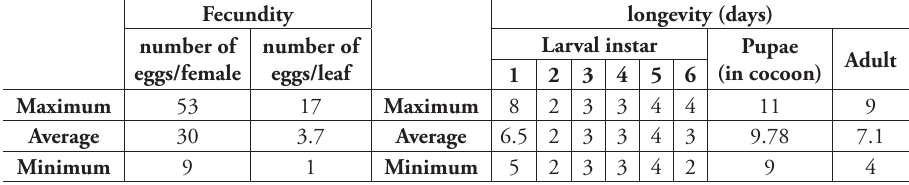
Table 1. Fecundity and longevity of N. oligospilus in laboratory. Females, n= 15; pupae, n = 15; larvae, n= 11 (from several instars); eggs, n=